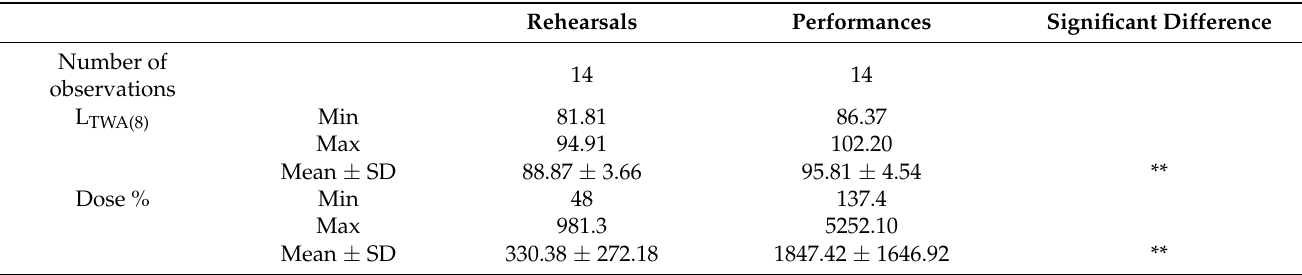
Table 3. Minima, maxima, means, and standard deviations of sound exposure among marching band members.